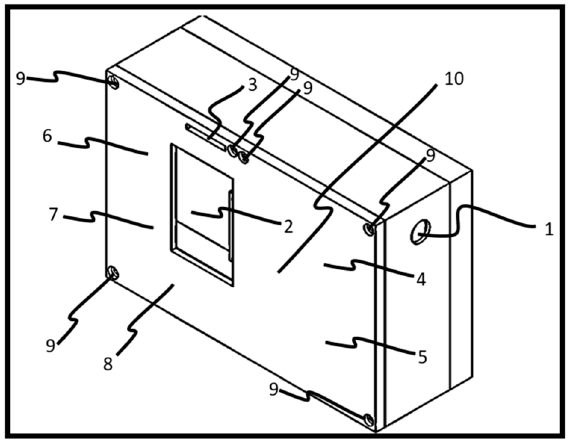
Figure 19. Design of back part of the SOMN_IA, with its main 10 components.